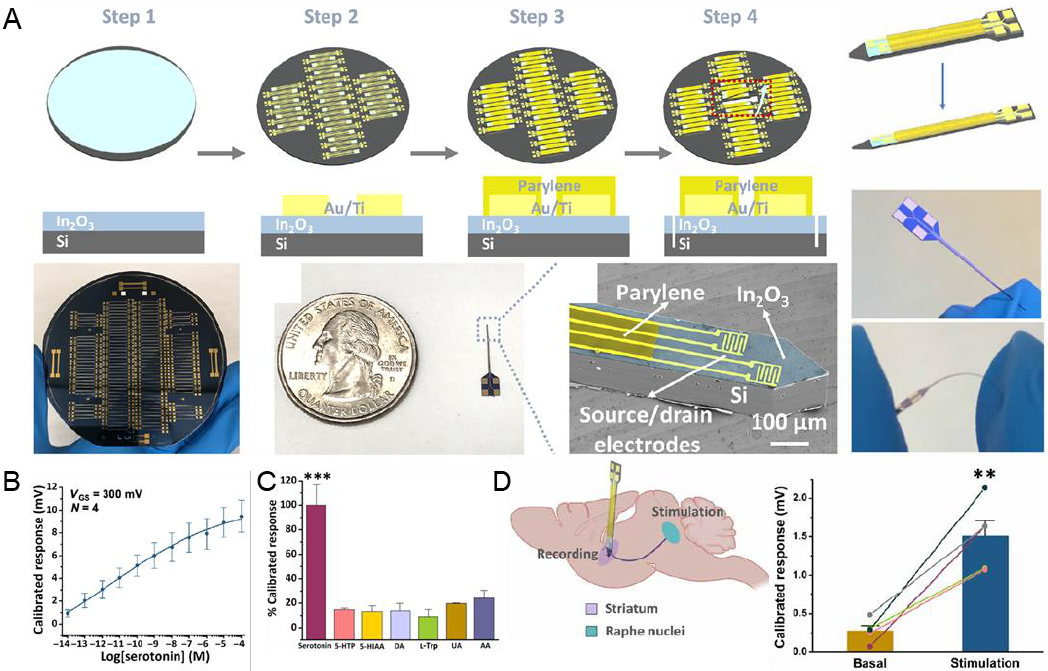
Figure 6. Polymer/metal-hybrid-based aptamer sensors for 5-HT detection. ( A ) Schematic illustration of the fabrication process of polymer/metal-hybrid-based aptamer sensors. ( B ) Linear plot indicating the linear range of 5-HT. ( C ) Selectivity of the fabricated aptamer sensor. ( D ) Schematic illustration of the in vivo 5-HT detection and the plot showing the detection performance. With permission from [69]. Copyright AAAS. L-5-HTP, L-5-hydroxytryptophan; 5-HIAA, 5-hydroxyindoleacetic acid; DA, dopamine; L-Trp, L-tryptophan; UA, uric acid; AA, ascorbic acid. ** p < 0.01, *** p < 0.001.